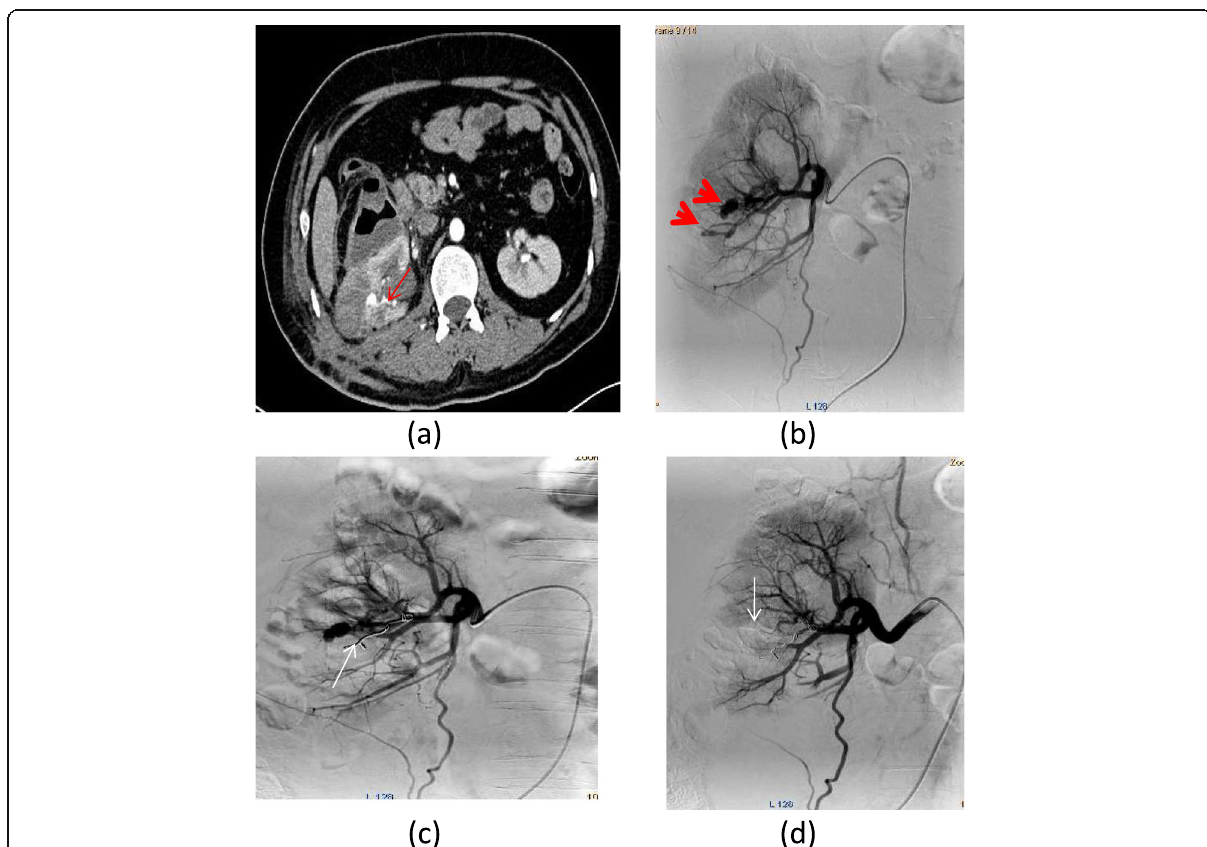
Fig. 2 Pre-embolization CT image ( a ) of a 45-year-old man who presented with bleeding after biopsy showing contrast extravasation in the right kidney (arrow). Pre-embolization DSA ( b ) revealed two pseudoaneurysmal lesions at the middle zone of the right kidney (arrow head) ( b ). After super- selective catheterization with a microcatheter, two micro-coils were inserted. Postembolization DSA ( c , d ) showed no filling of the